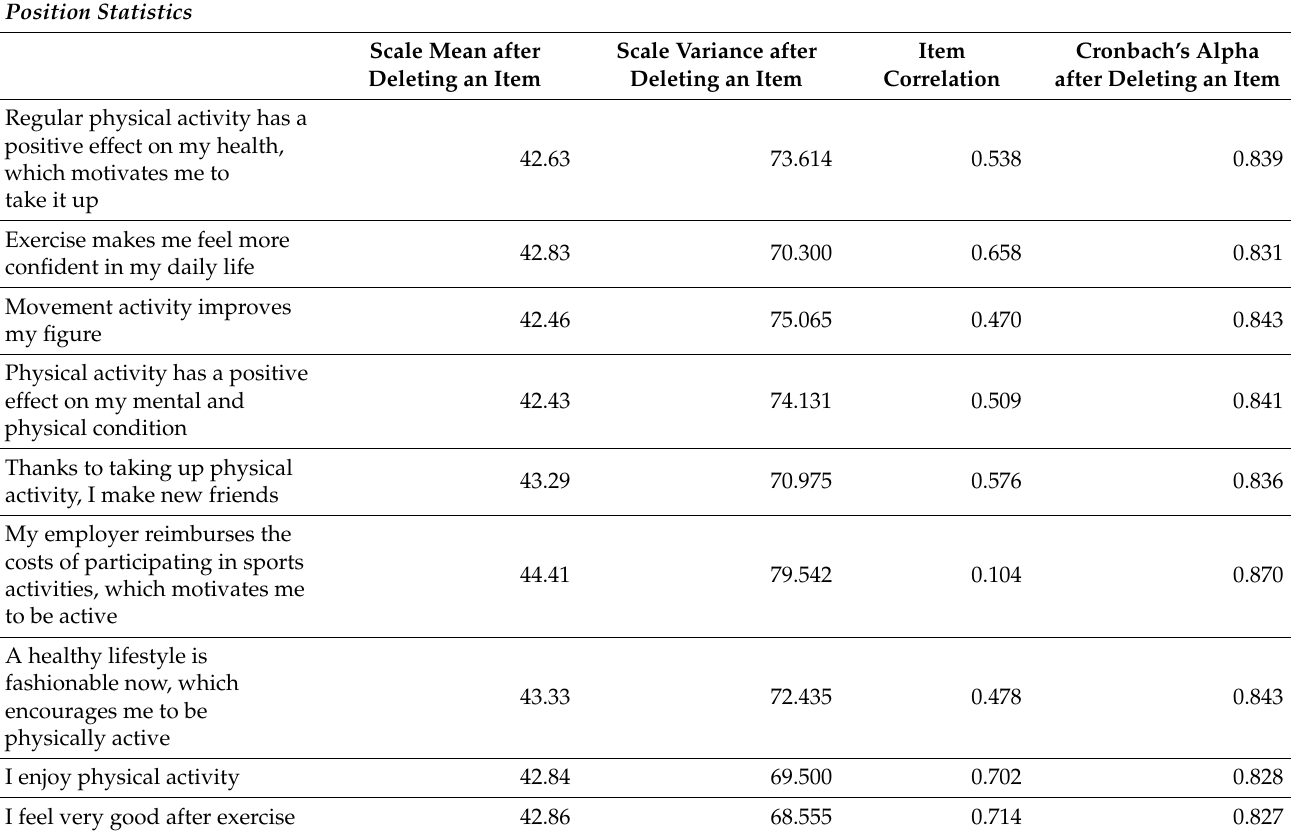
Table A1. The full list of statements accessing the motivators to participate in regular PA in the nurse population and their consistent validity